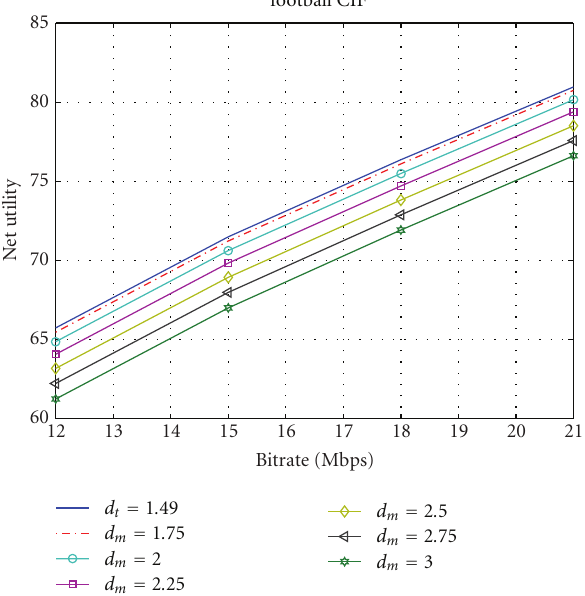
Figure 15: Net utility function versus rate at various values of parameter d for sequence football. CIF: d t = true value, and d m = misreprted value.